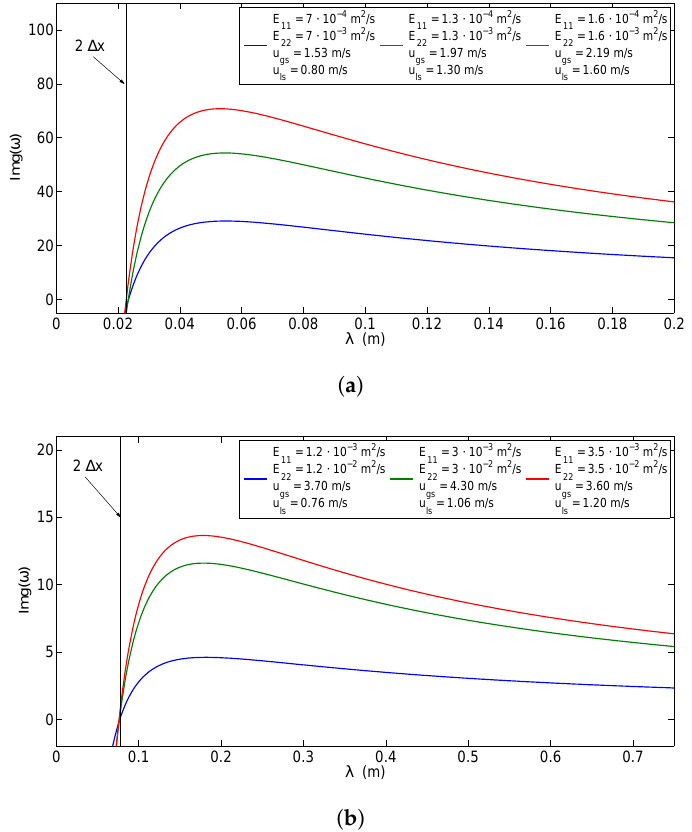
Figure 3. Plot of the amplification factor for different couples of inlet superficial velocities. ( a ) Amplification factor for geometry Pipe1; and ( b ) amplification factor for geometry